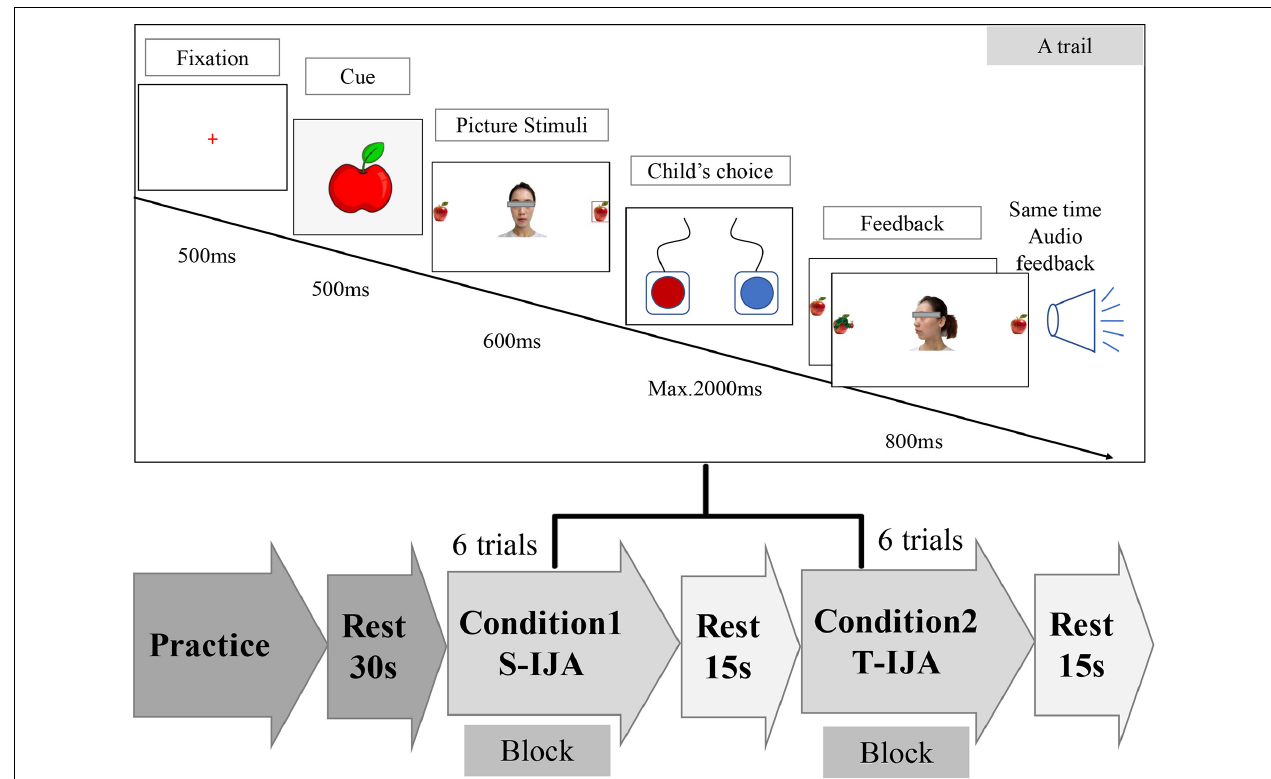
FIGURE 1 | The Initiating Joint Attention (IJA) task schematic. The experiment consisted of two kinds of social partners (i.e., stranger and teacher) in the IJA task, and considered two conditions, i.e., Condition 1 (S-IJA, corresponding to interaction with the stranger), and Condition 2 (T-IJA, corresponding to interaction with the teacher). Each condition was a block that included 6 trials and would be repeated three times in the experiment. In an IJA trial (see the top of the figure), participants were asked to freely choose to shift the gaze of the interacting partner (teacher/stranger) by pressing the left or right button. The partner (teacher/stranger) shifted his/her gaze leftward or rightward dependent on the participant’s